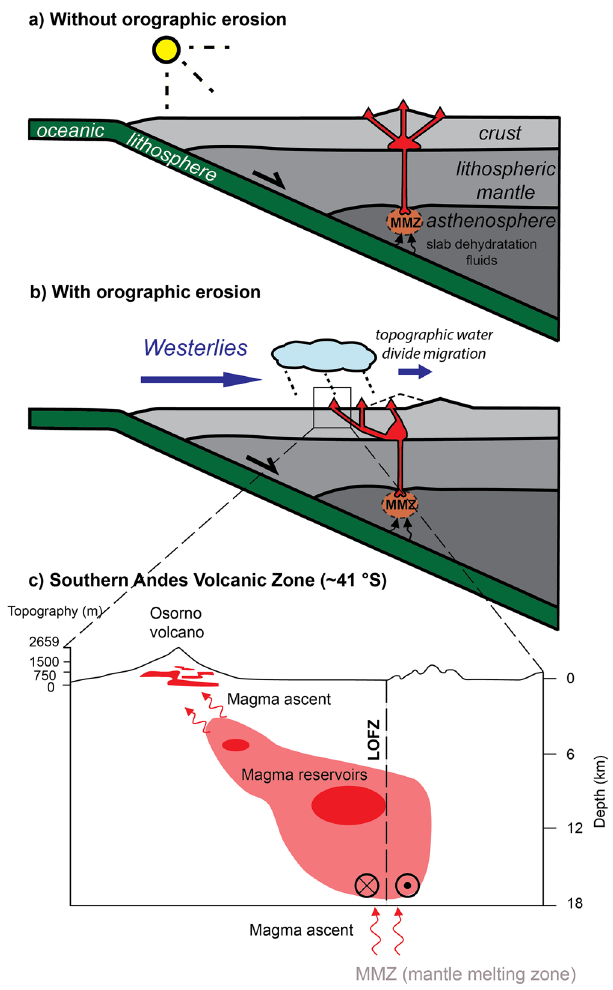
Figure 5. Schematic representation of the orographic forcing on the location of continental volcanic arcs. Cross-sections illustrate the magma ascent from a sub-lithospheric mantle melting zone (MMZ) to surface volcanoes (red triangles) trough newly-formed or reactivated structures. ( a ) Analogy for orogens and volcanic arcs without orographic erosion, and b ) with orographic erosion gradient. In the latter case, the deformation is enhanced on the windward side and so is the magma ascent through the brittle-ductile structures. ( c ) Schematic representation of the crustal magma reservoirs interpreted from magnetotelluric data underneath the Osorno volcano showing the marked westward magma ascent in agreement with our modeling results and the proposed orographic effect on the location of the volcanic arc front (modified after Ref. 70